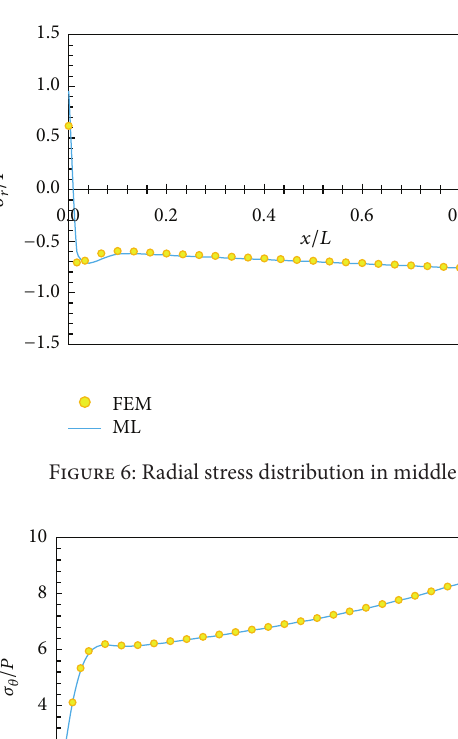
Figure 8: Radial displacement distribution in different layers.